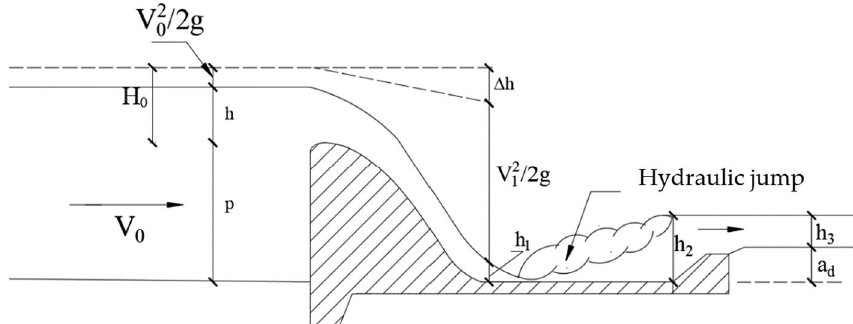
Fig. 1 Hydraulic jump in the stilling basin. a 1.7 < Fr < 2.5 pre-jump stage. b 2.5 < Fr < 4.5 transition jump. c 4.5 < Fr < 9; balanced jump. d Fr > 9; effec- tive